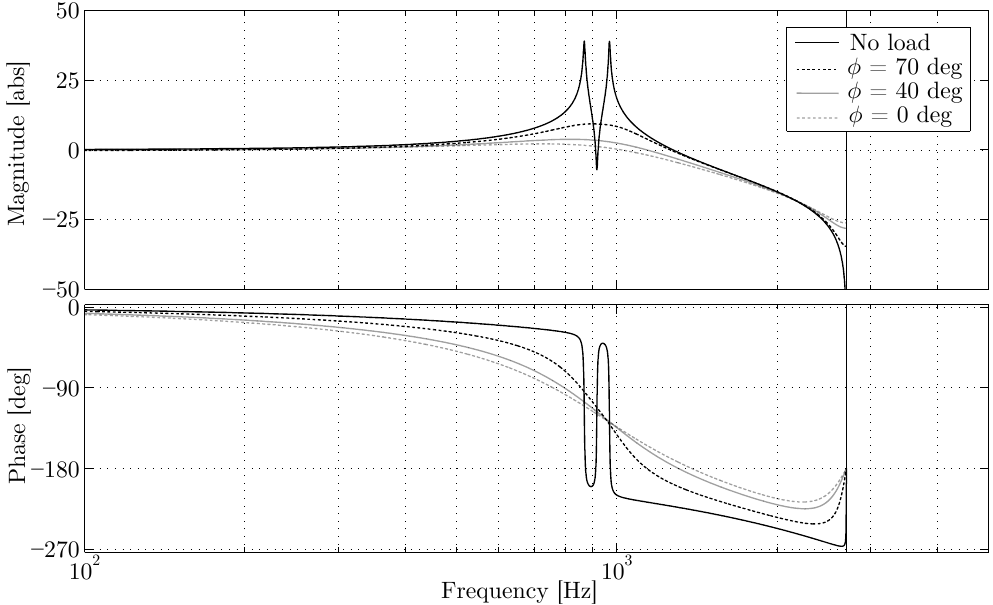
Figure 18. Frequency response of the plant when using a parallel RL load, for different values of φ ( φ is the angle of the load impedance). In all cases (except in the one called “no load”) the load consumes the nominal current at the rated